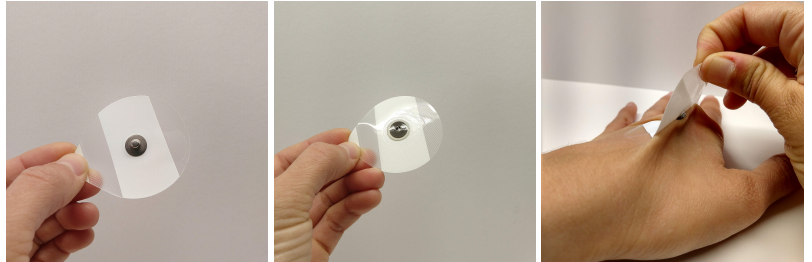
Figure 1. Front and back of a traditional electrode and the skin discomfort caused by the adhesive